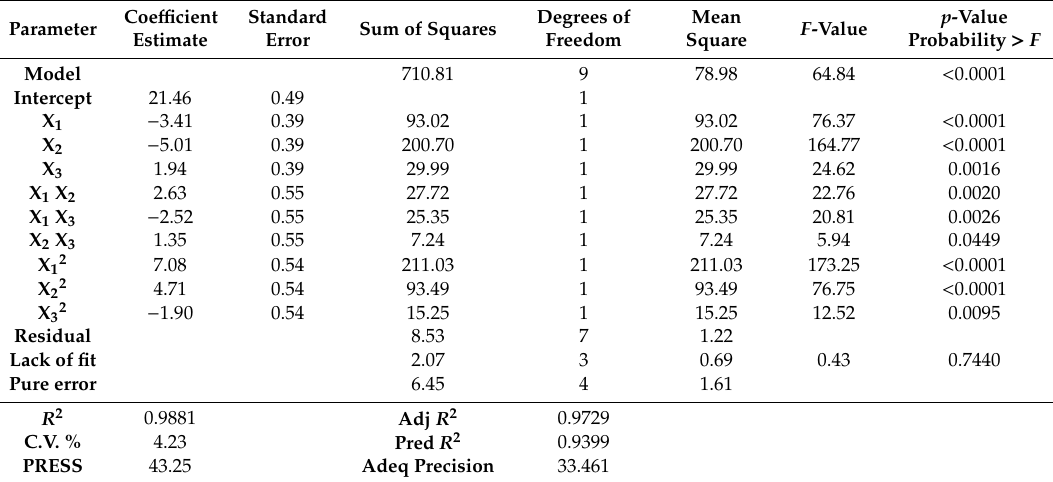
Table 2. The values of regression coe ffi cients and analysis of the model for extraction yield. Parameter